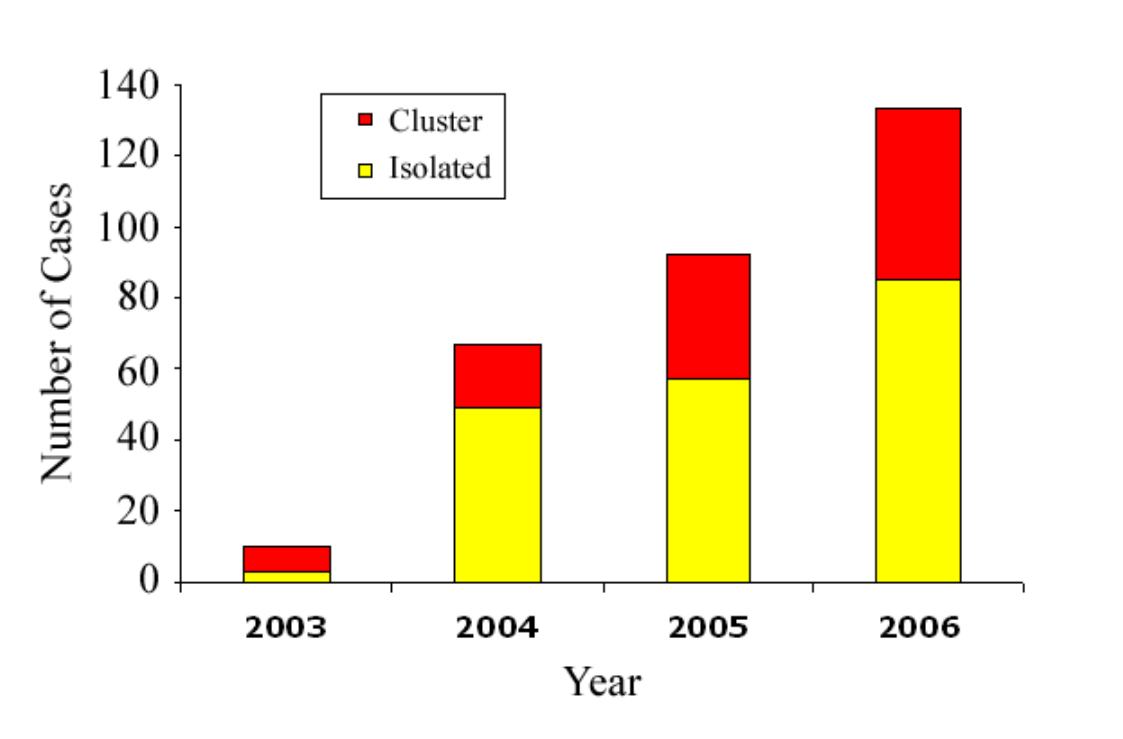
Fig. 3. Proportion of reported confirmed human H5N1 cases associated with human disease